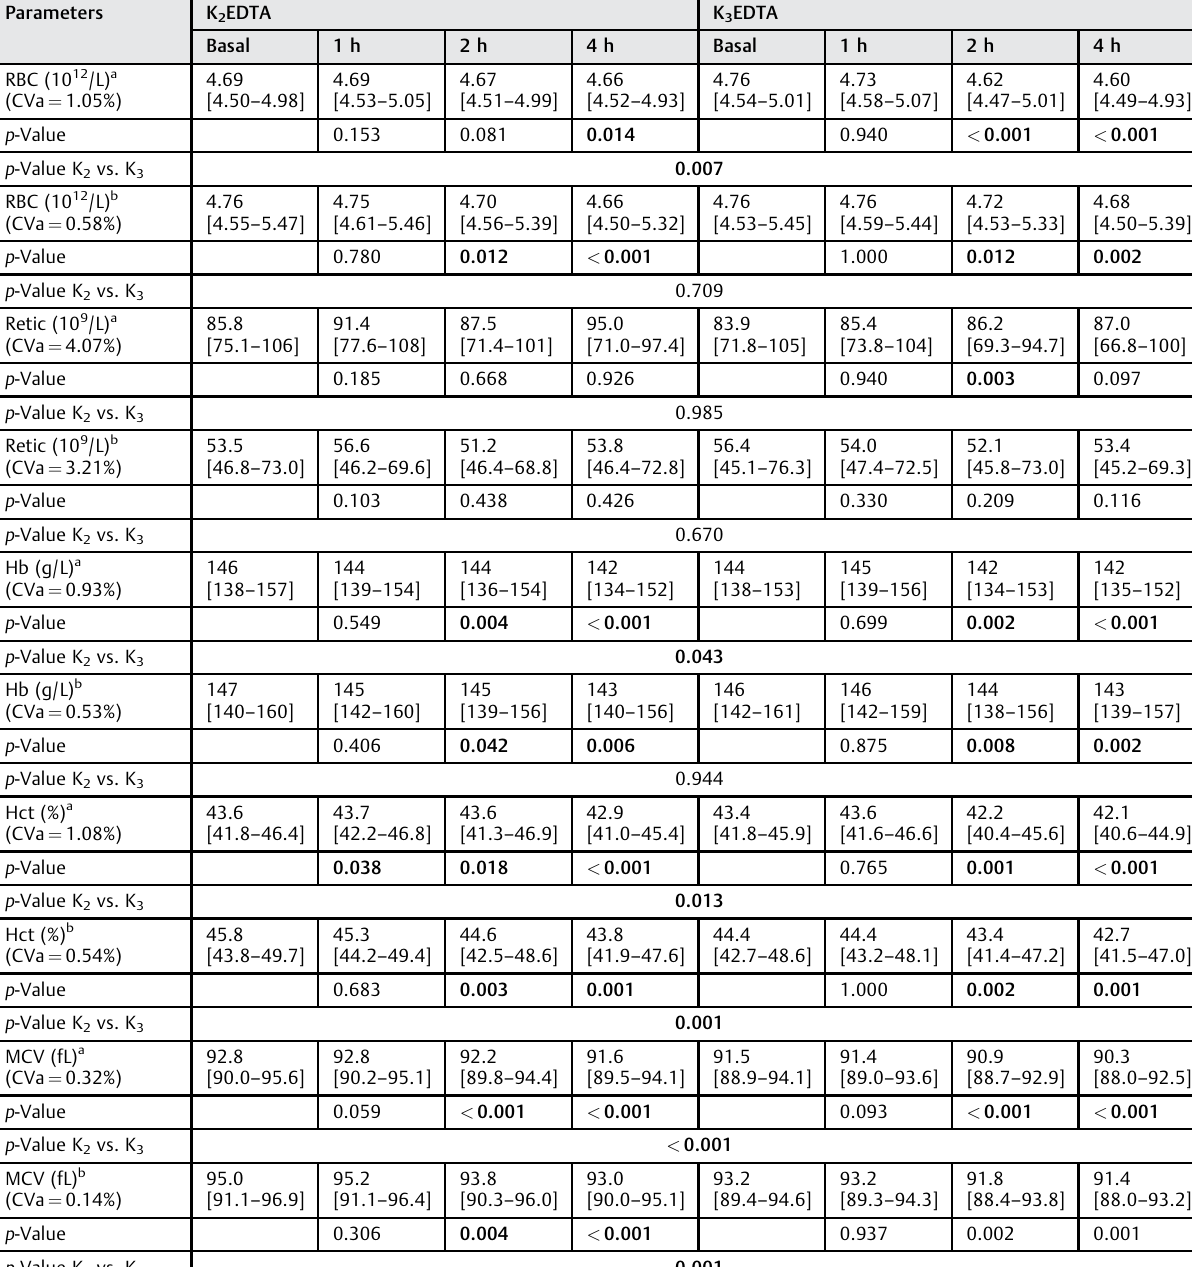
Table 2 Postprandial variation on complete blood count after Chilean breakfast Parameters